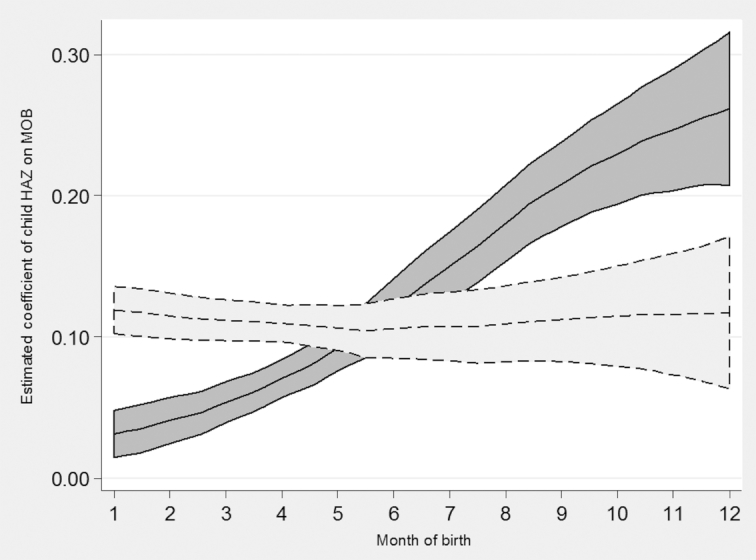
Estimated coefficients of child HAZ on MOB across 5 DHS in Zambia. Lines are local polynomial smoothing regressions of degree zero with 95% CIs and an Epanechnikov kernel. Solid line is estimates before the linear correction for misreported MOB. Dotted line is after the linear correction for misreported MOB. DHS, Demographic and Health Surveys; HAZ, height-for-age z-score; MOB, month of birth.